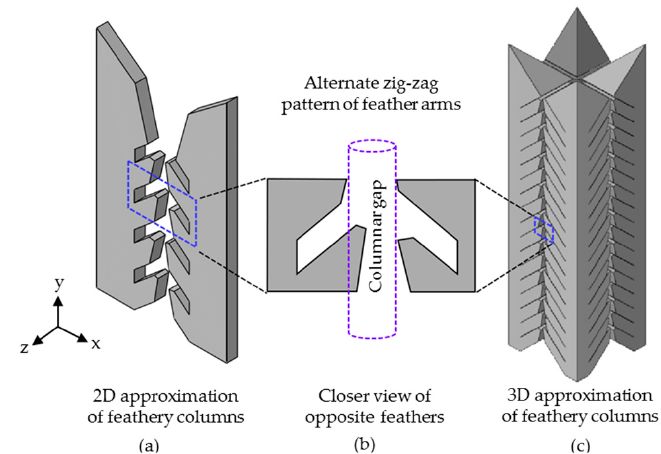
Figure 5. Microstructure unit cell (MUC) for infiltration analysis: ( a ) a two-dimensional (2D) representation of feathery columns with sideway periodic arrangements; ( b ) fine details of the feather tips idealized form real tortuous feathery structures; and ( c ) a three-dimensional (3D) representation of MUC consisting of four one-eighth feathery columns, arranged with alternate zigzag patterns of feathery structures.